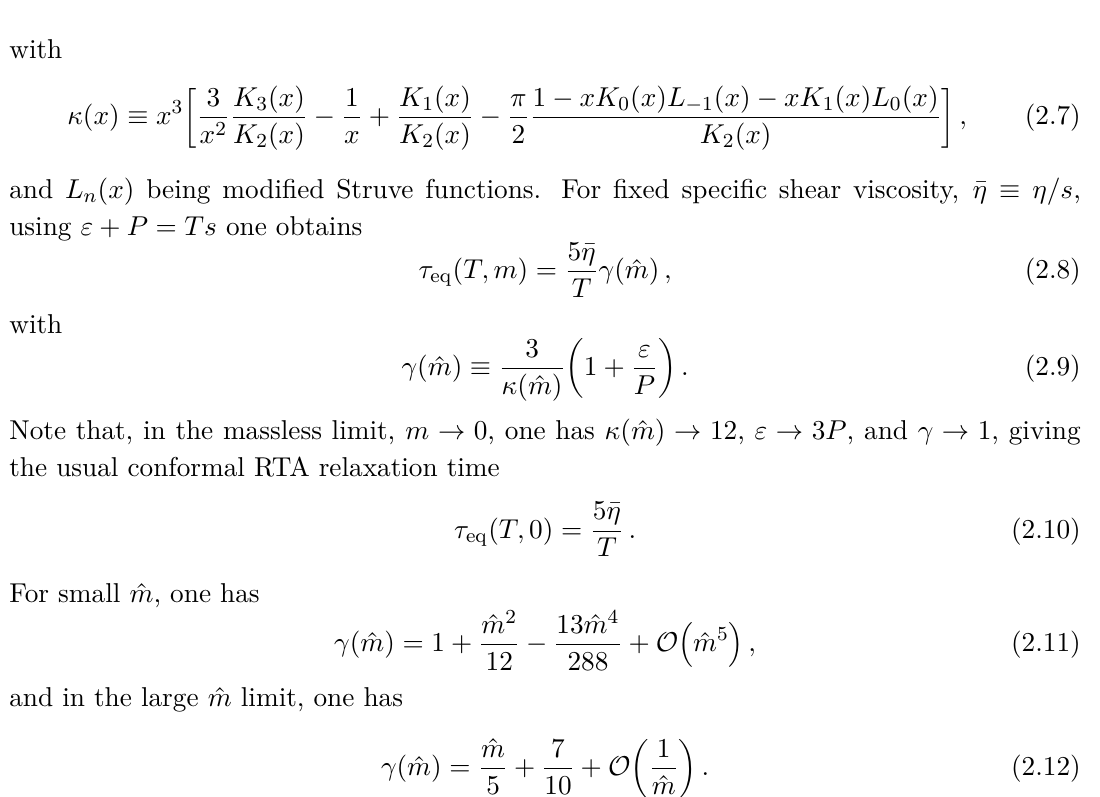
Figure 1 . The non-conformal relaxation time modification factor γ (2.9) as a function of m/T